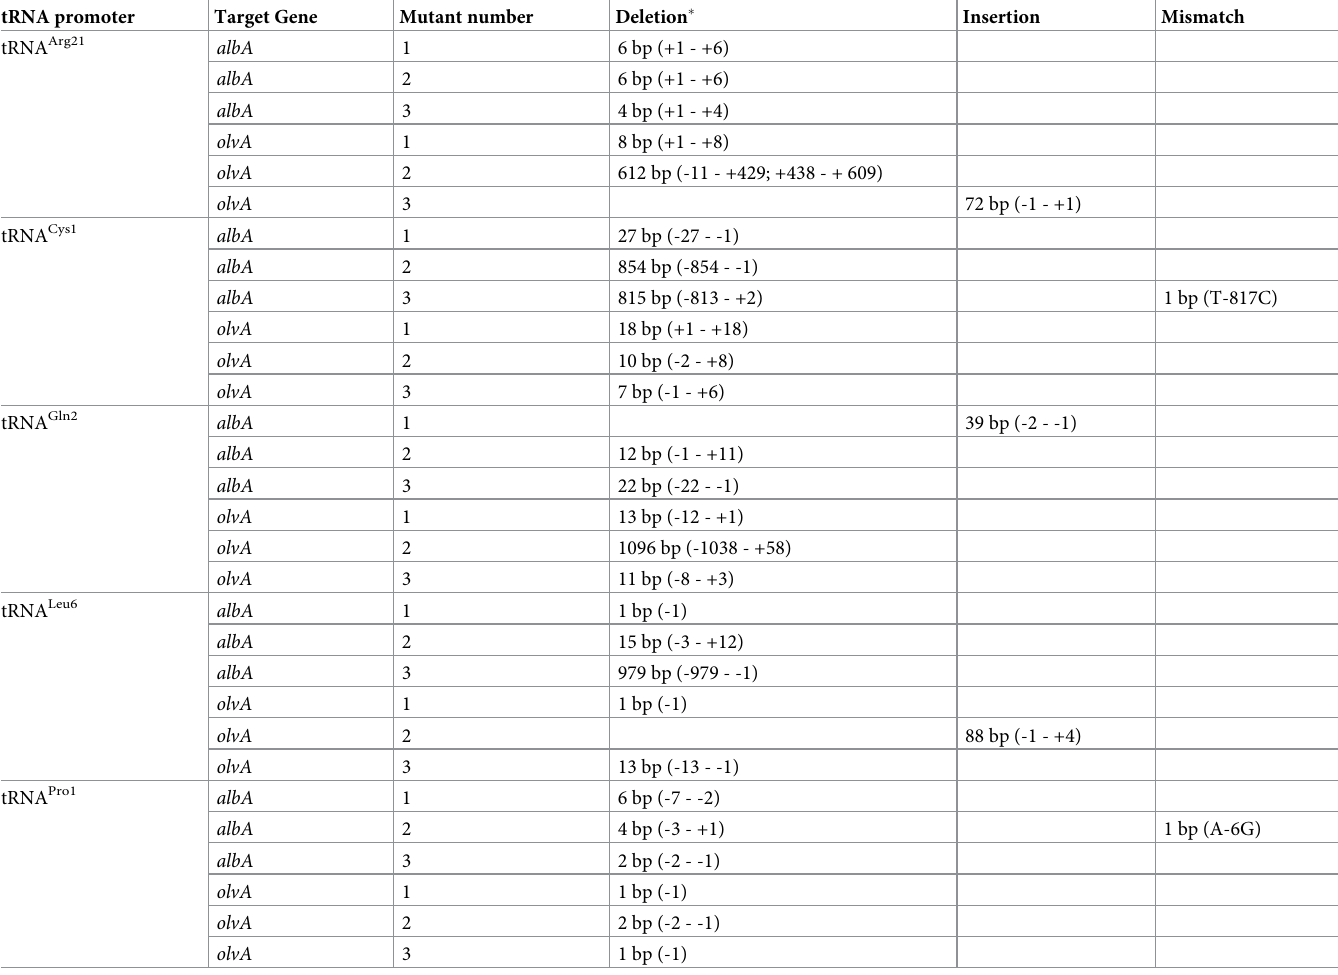
Table 4. Mutations generated by tRNA promoter-driven CRISPR/Cas9 mutagenesis.